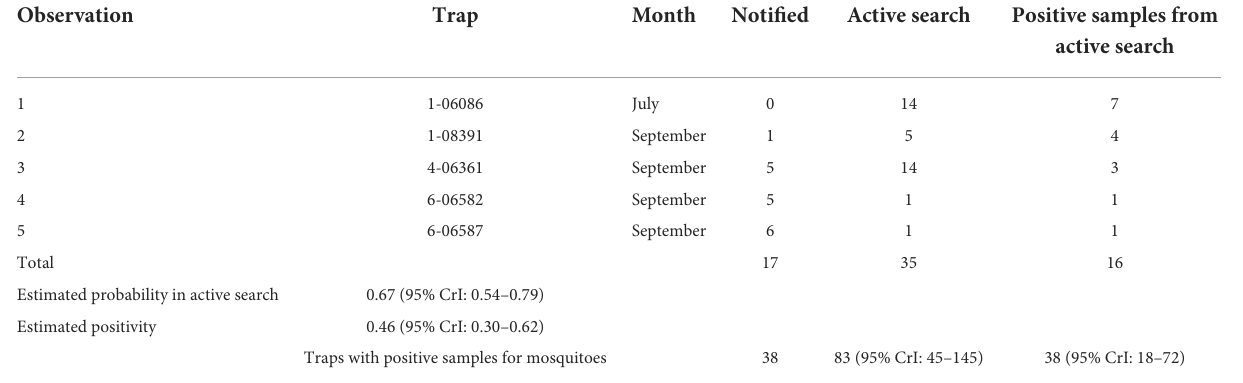
TABLE 1 Observations per trap and estimations from the model.